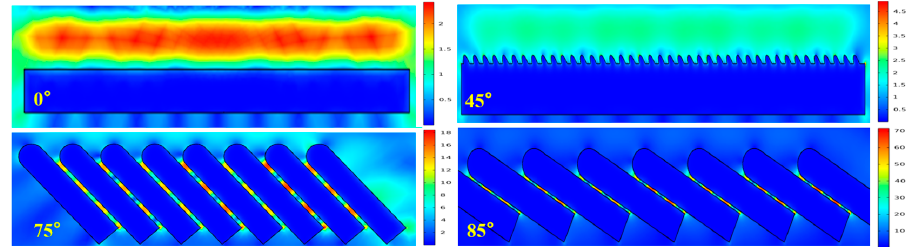
Figure 14. Electric field distribution diagram of Ag film obtained from different deposition angles.